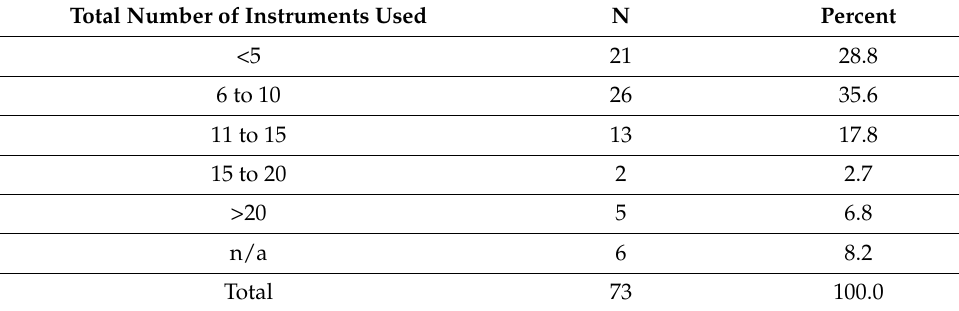
Table 2. Total number of assessed outcomes